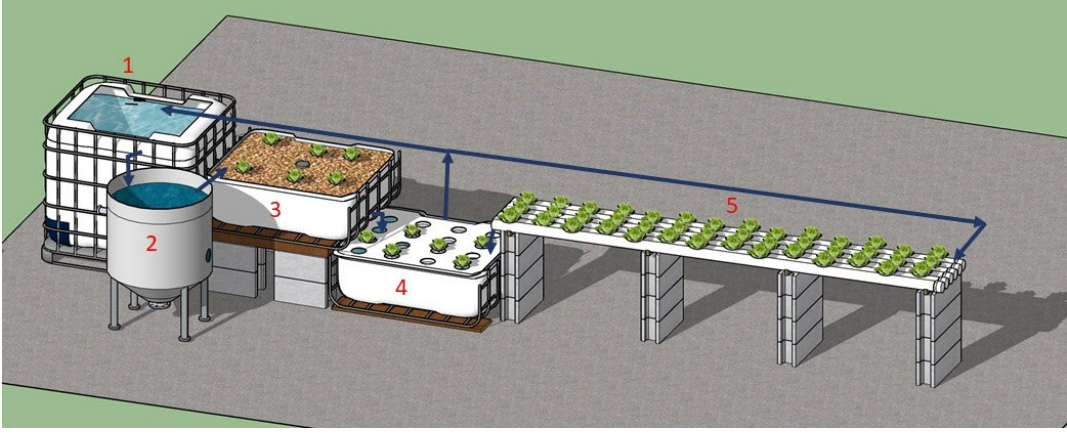
Figure A1. Schematics of the SAS: (1) fish tank; (2) clarifier; (3) biofilter and media bed; (4) sump and floating raft; (5) NFT. Blue arrows represent the direction of the water flows.